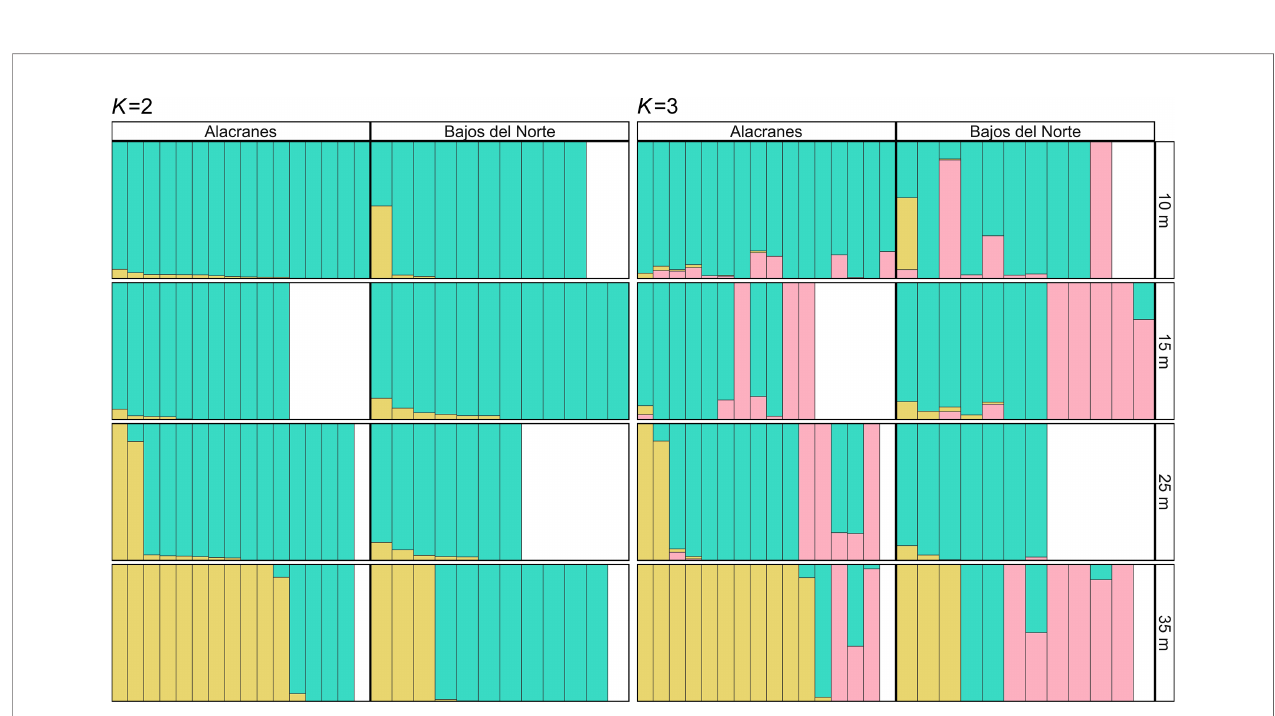
FIGURE 4 | Population structure models generated for Montastraea cavernosa coral host populations across the four depth zones and two reefs. The Evanno and Puechmaille methods were used to estimate the optimal values of K , and the models K =2 and K =3 were selected as the most likely number of genetic clusters, represented by the colors turquoise, yellow, and pink. Each bar indicates individual M. cavernosa samples and the relative proportion of the three colors represent the relative likelihood of membership to each of the two or three proposed genetic